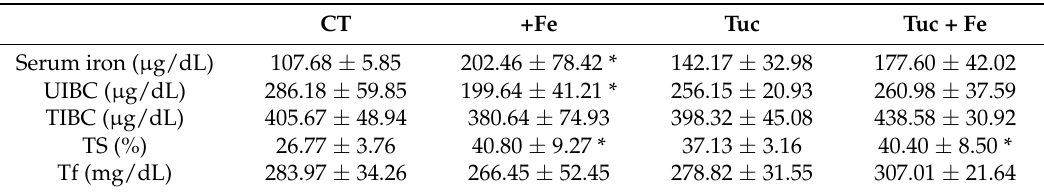
Table 3. Effect of iron and/or tucum-do-cerrado in the serum iron parameters of adult rats treated for 12 weeks.